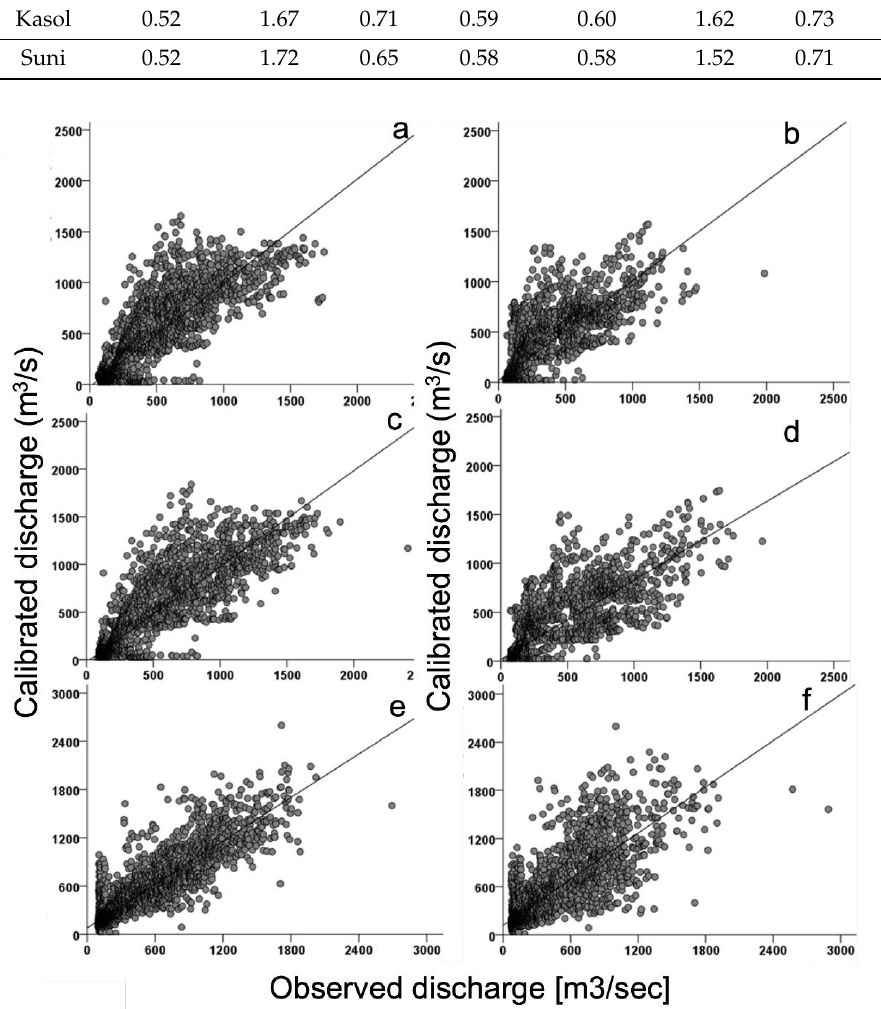
Figure 2. Daily calibration (1991–2000) and validation (2001–2008) vs. observations at three outlets: ( a ) Rampur calibration; ( b ) Rampur validation; ( c ) Suni calibration; ( d ) Suni validation; ( e ) Kasol calibration; ( f ) Kasol validation.